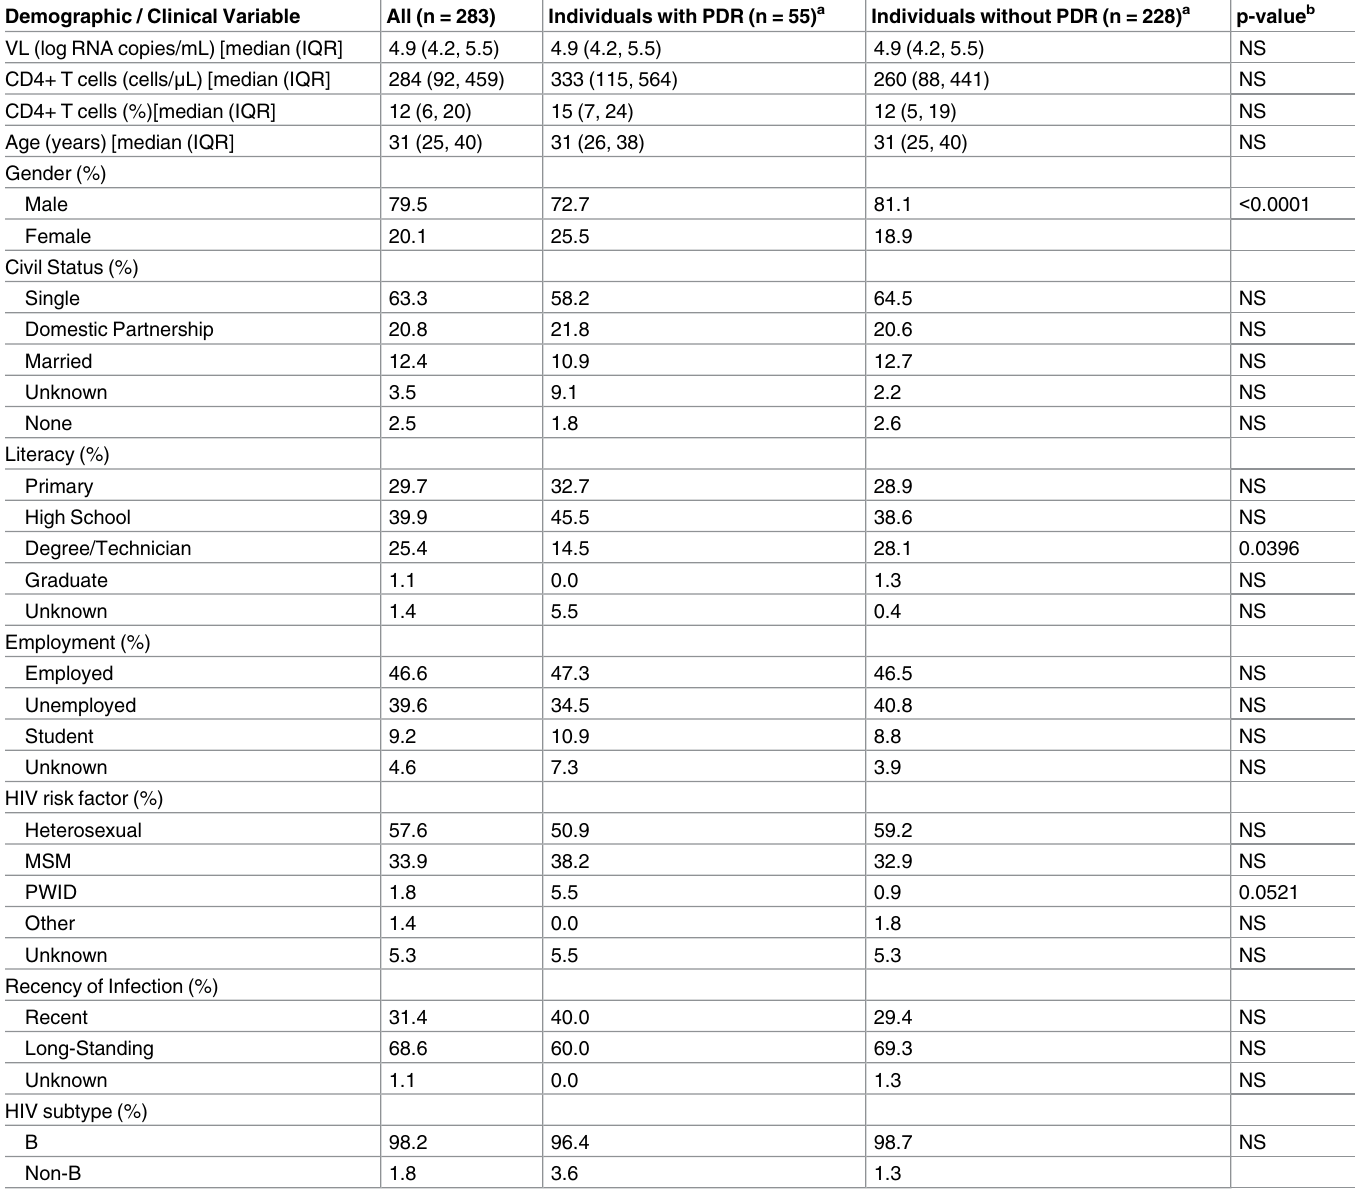
Table 1. Demographic and clinical characteristics of the